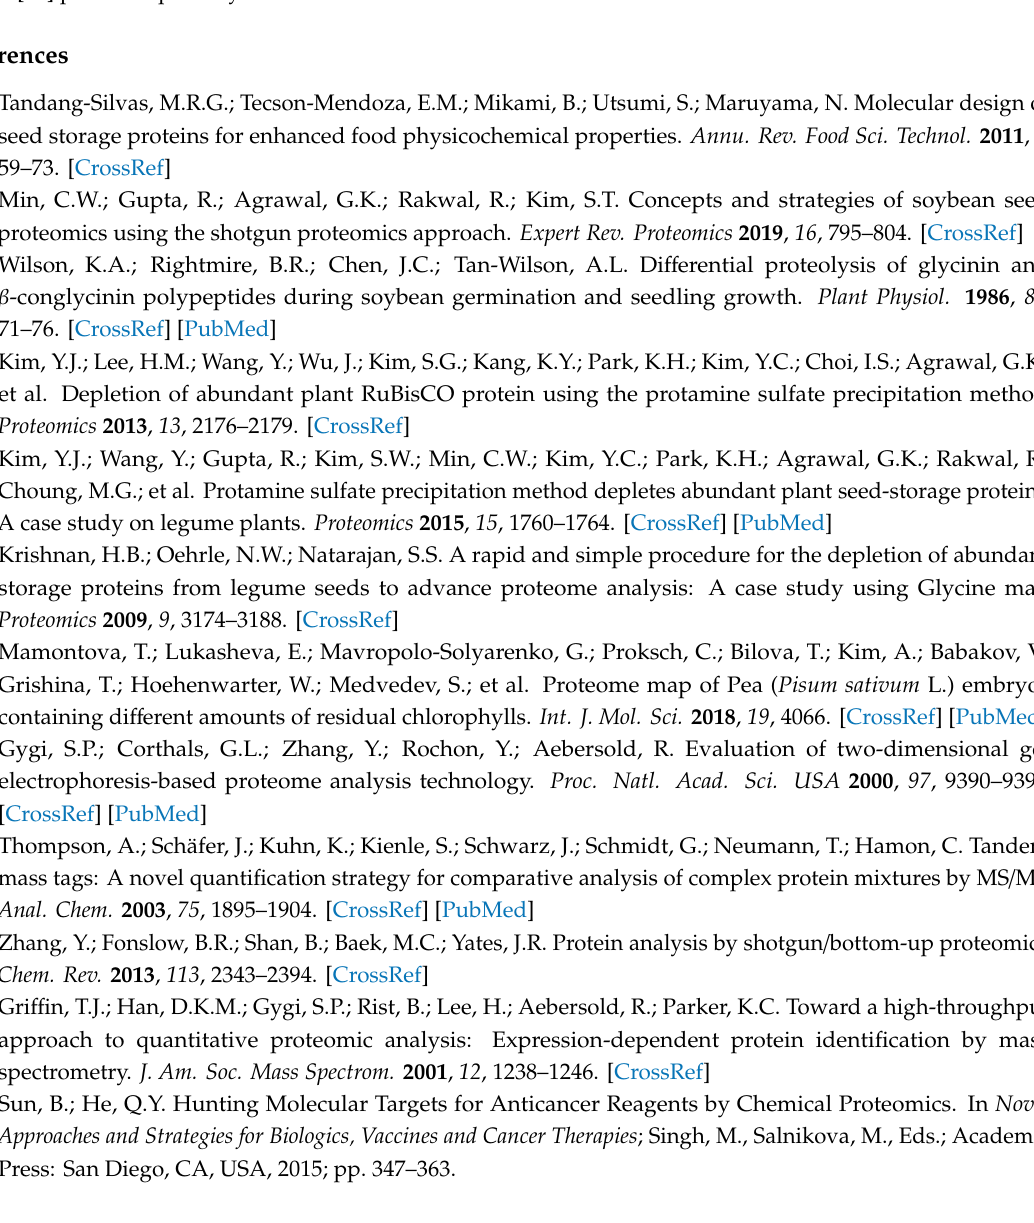
MapMan functional classification of di ff erential proteins in filling stage samples, Table S1: Identification of di ff erentially modulated proteins in the matured seeds by TMT-based quantitative proteomic analysis, Table S2: GO enrichment and MapMan analysis of di ff erential proteins in the matured seeds, Table S3: Identification of di ff erentially modulated proteins in the filling stage seeds by TMT-based quantitative proteomic analysis, Table S4: GO enrichment and MapMan analysis of di ff erential proteins in the filling stage